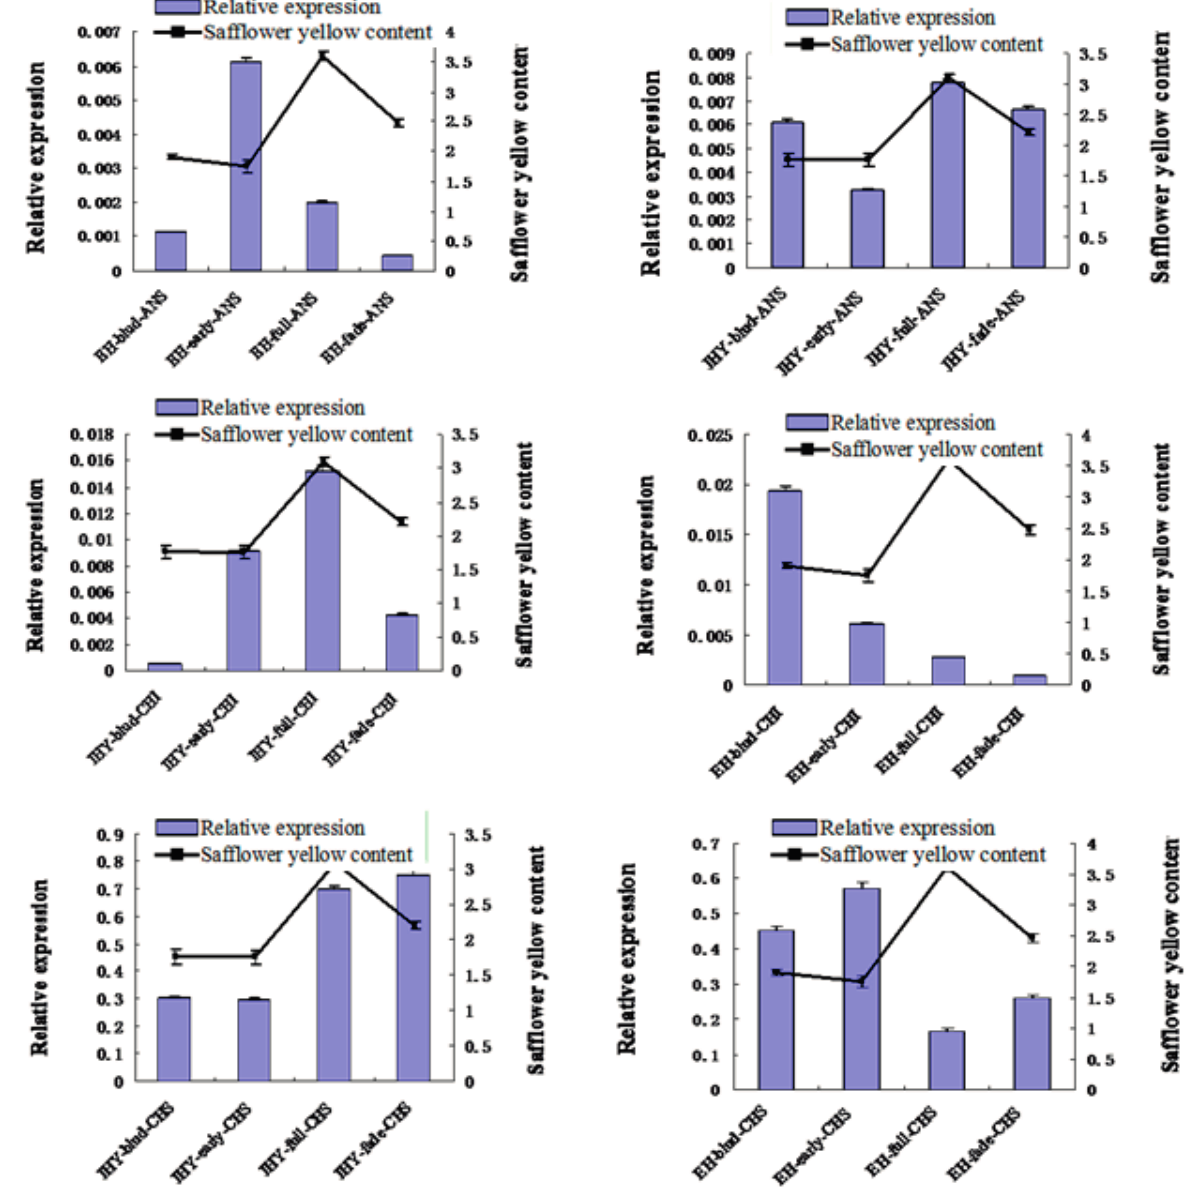
Figure 10. Relationships among the relative expression levels of the three genes and the content of Safflower yellow pigments during flower development in different varieties. HY, Jihongyou var.; EH, Jihongerhao var.; bud, early, full and fade indicate the flowering stages; CHS, chalcone synthase; CHI, chalcone isomerase; and ANS, anthocyanidin synthase.